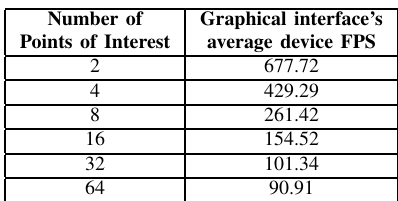
TABLE IV D EVICE FPS – T HIRD MEASUREMENT